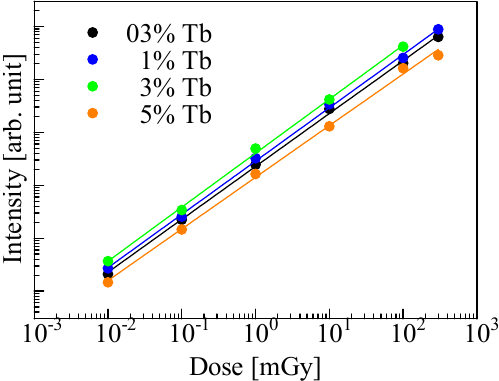
Figure 8. TSL dose response functions of Tb-doped MgGa 2 O 4 .